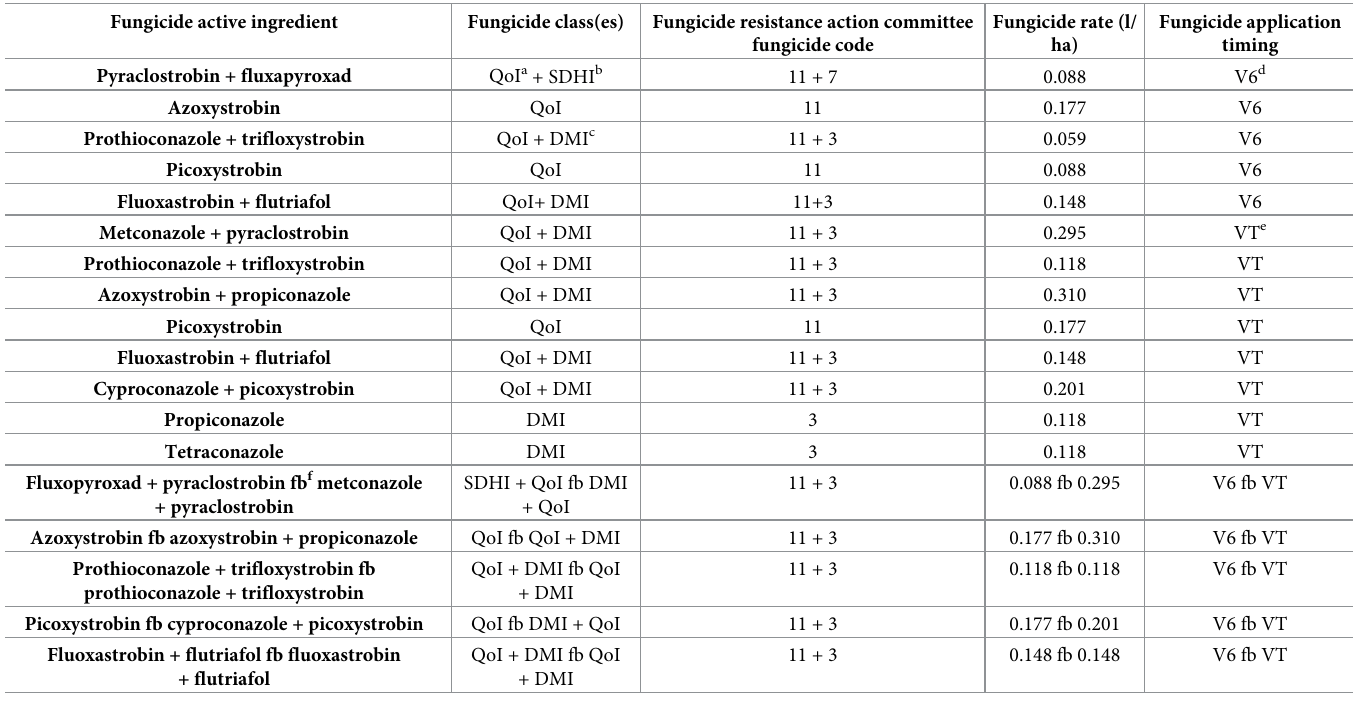
Table 1. Fungicide product information and application timing for uniform fungicide application timing trials conducted in 2014 and 2015 in the United States and Ontario, Canada.